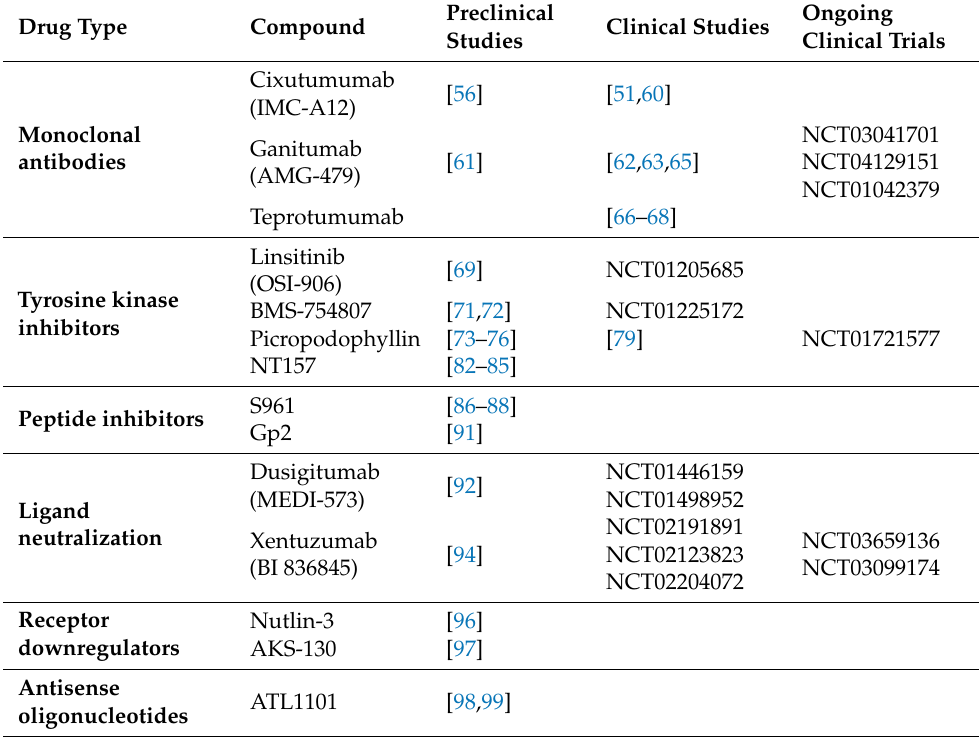
Table 1. Strategies of targeting IGF1R and IR in